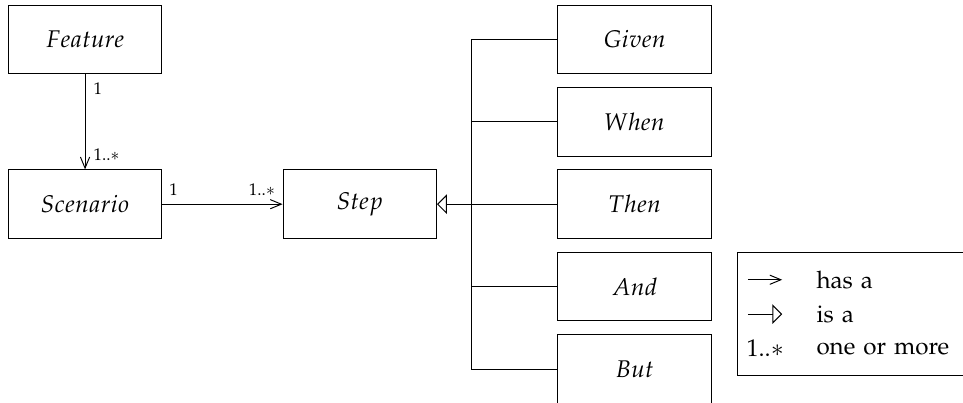
Figure 1. The structure of Gherkin keywords in a feature TDD has been applied at all levels from acceptance testing to unit testing [22,23]. TDD has 90 demonstrated successes among early adopters in IoT development (e.g., [4]).